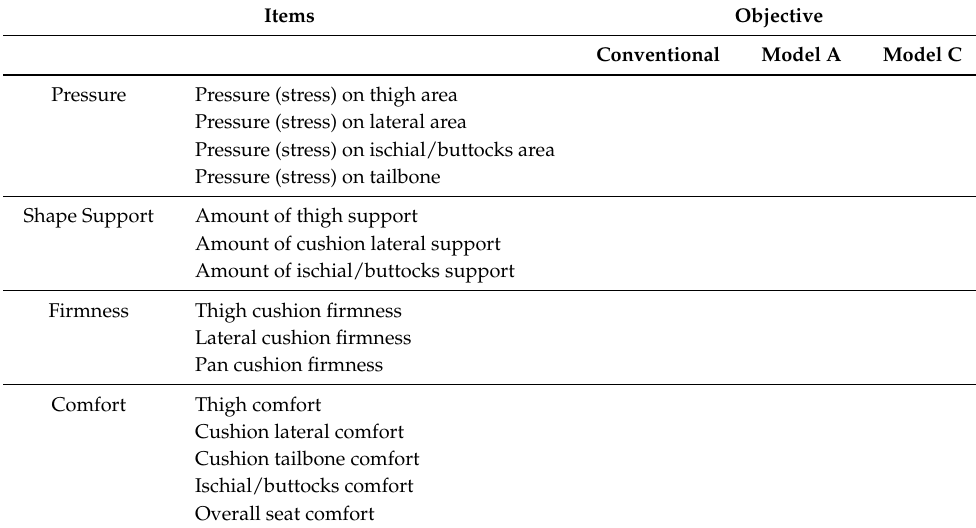
Table 1. The questionnaire for subjective